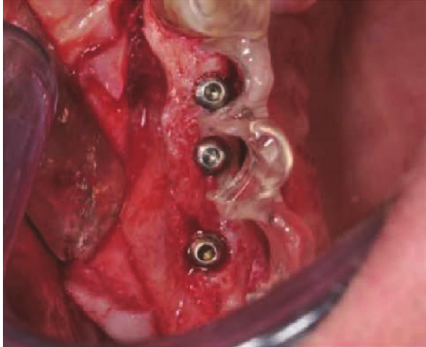
Figure 12: Implants